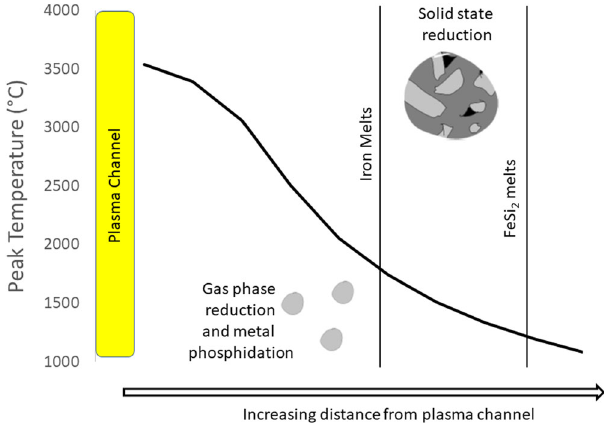
Fig. 7 Schematic of the two routes to phosphate reduction within the NPR fulgurite. The high-temperature reduction is rapid due to gas-solid reactions, and occurs closer to the plasma discharge, and the low- temperature reduction occurs in the solid phase and is likely kinetically inhibited from proceeding to form phosphides. Known temperature points are the melting point of the Ca – Al – Si matrix (1195 °C), the melting point of FeSi 2 (1220 °C), the melting point of iron metal (1538 °C), the melting point calcium phosphate (>1600 °C), and the melting point of SiO 2 (1710 °C). SiO 2 is glass near the interior of the fulgurite, whereas it is a crystalline material on the exterior, showing a radial temperature pro fi le that has been reported previously 25 .